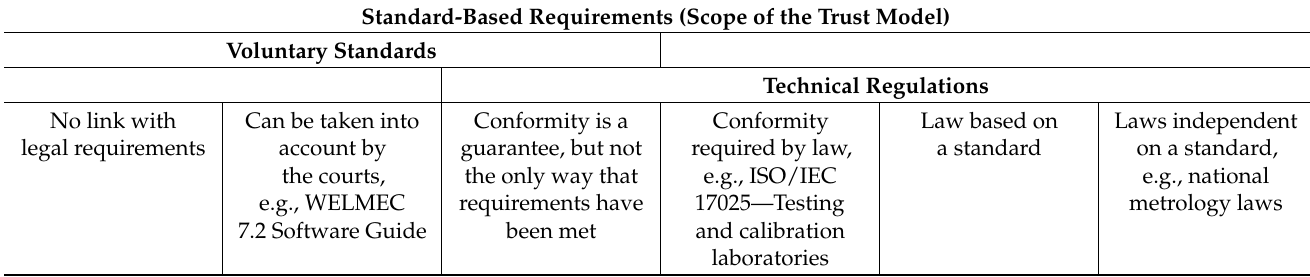
Table 2. Normative standards and legal requirements according to